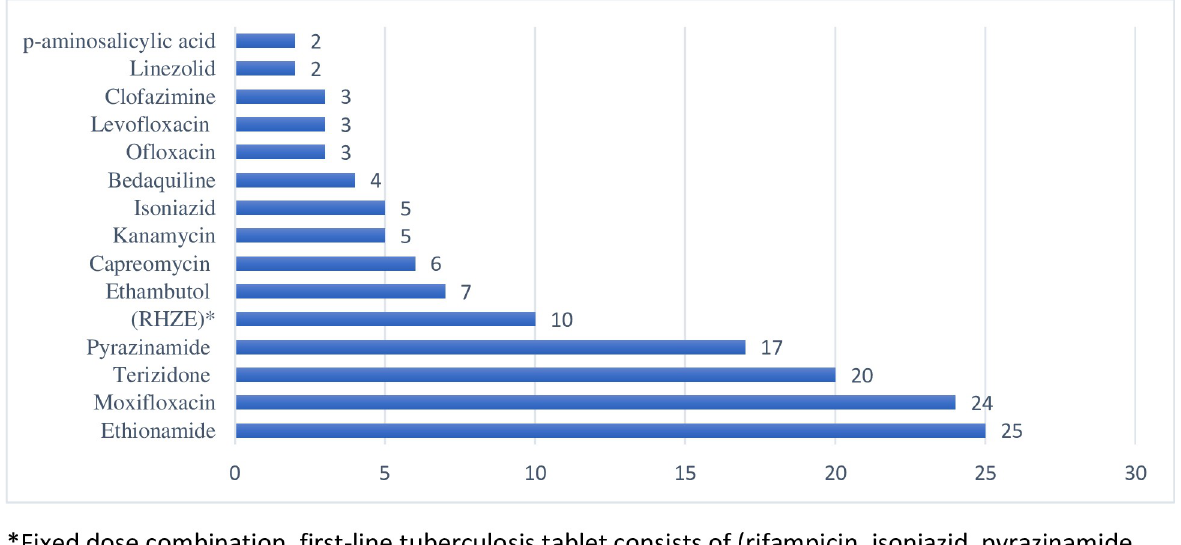
Fig 1. Frequency of tuberculosis drugs used in the study cohort. � Fixed dose combination, first-line tuberculosis tablet consists of (rifampicin, isoniazid, pyrazinamide and ethambutol).